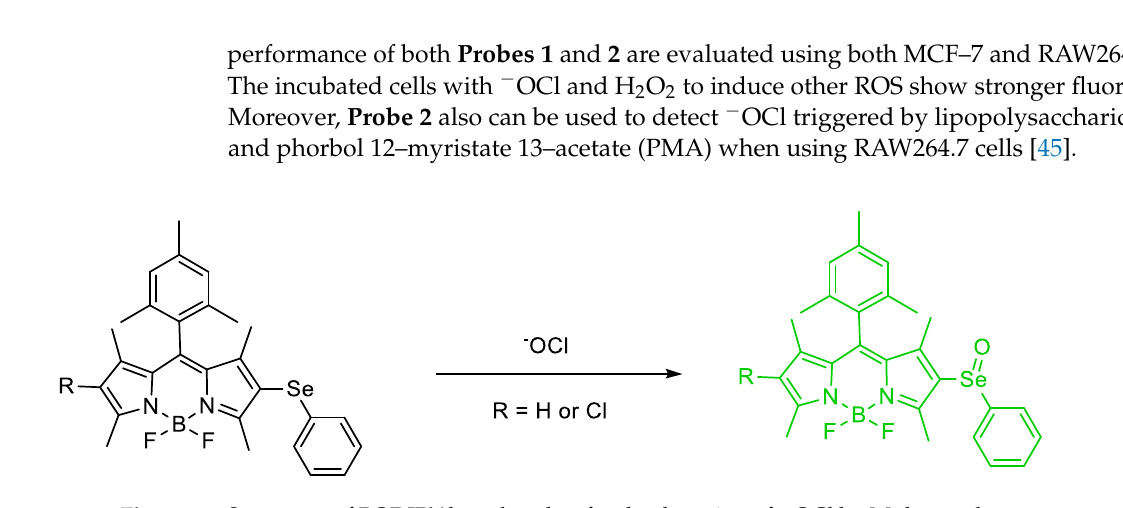
Figure 38. Compound 7f squarine compound by Martin et al.